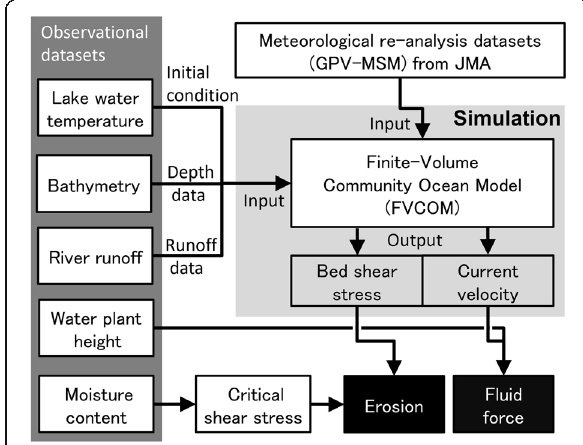
Fig. 3 Flowchart of the erosion and fluid force evaluation based on the simulated results of the FVCOM (center gray-shaded square) using the observed datasets (left, gray-shaded group) and meteorological reanalysis datasets (upper white